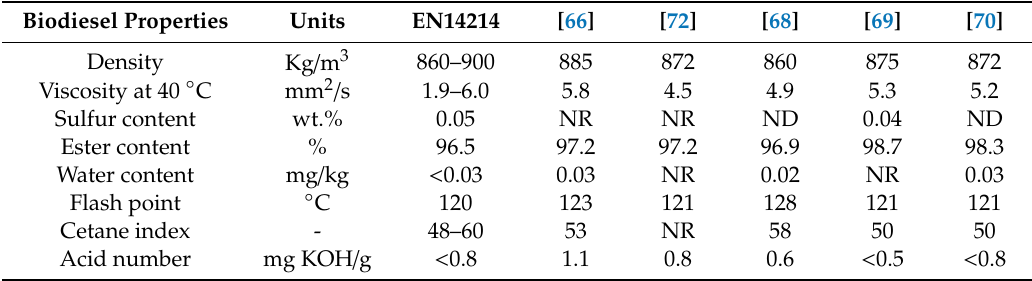
Table 2. Properties of biodiesel from BSFL reared on di ff erent